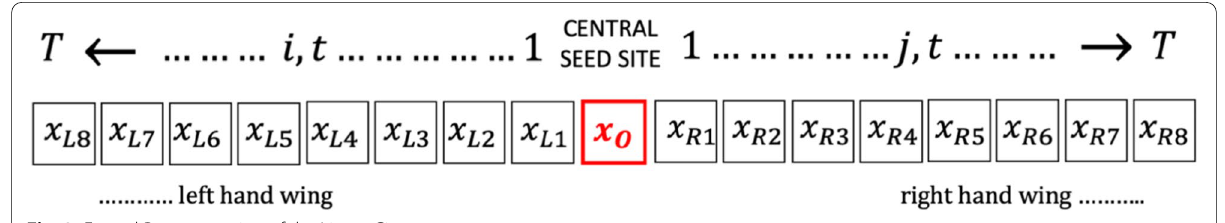
Fig. 3 Formal Representation of the Linear